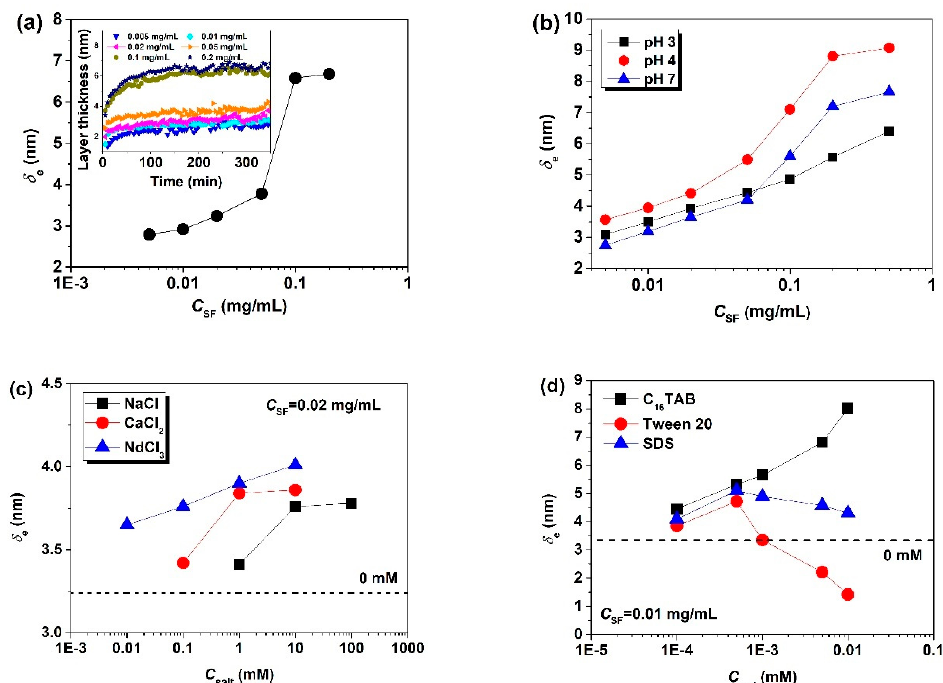
Figure 2. Influences of solution conditions on the equilibrium thickness ( δ e ) of the adsorbed layers formed by SF at the air/water interface: ( a ) influence of C SF ; ( b ) influence of pH; ( c ) influence of salts; ( d ) influence of surfactants (taken from [34 − 37]).